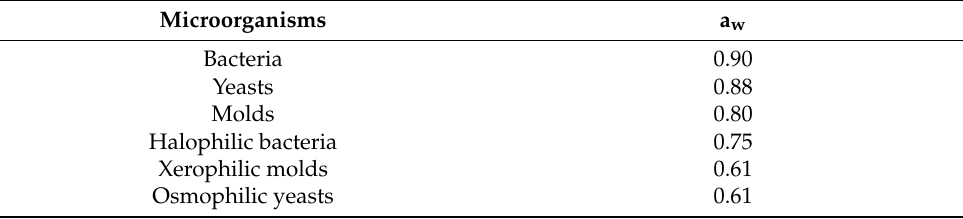
Figure 5. Sorption isotherm [28]. Table 5. Minimum a w values for the growth of microorganisms.